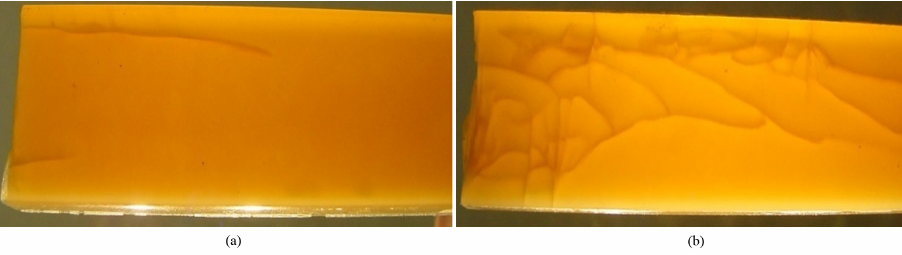
Figure 5. Macrophotographic images of the surface of PHB-2 samples after tensile testing, (a) exposed to NaOH at 1.0 mm/min, (b) exposed to NaOH at 0.1